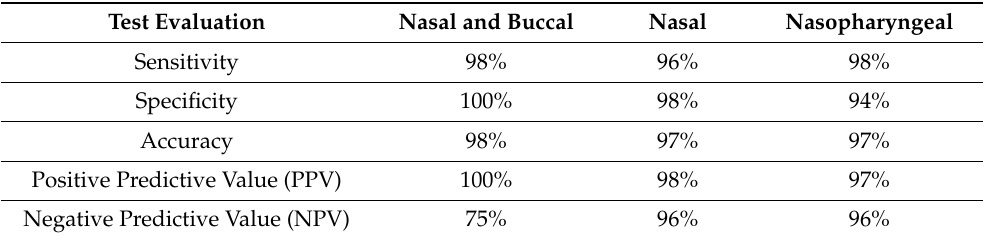
Table 3. Sensitivity, specificity, accuracy, PPV, and NPV of different respiratory samples in comparison with qRT-PCR.